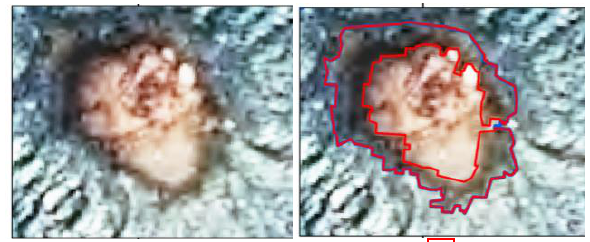
Figure 8. Islet shoreline